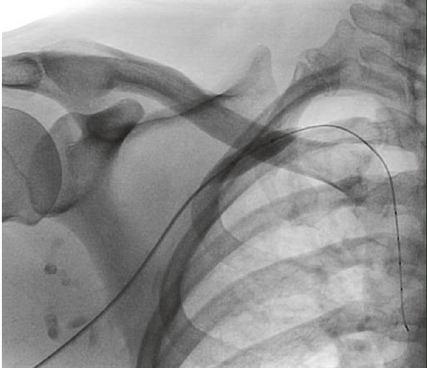
Figure 1: Doppler ultrasound showing absence of blood flow in the subclavian vein.